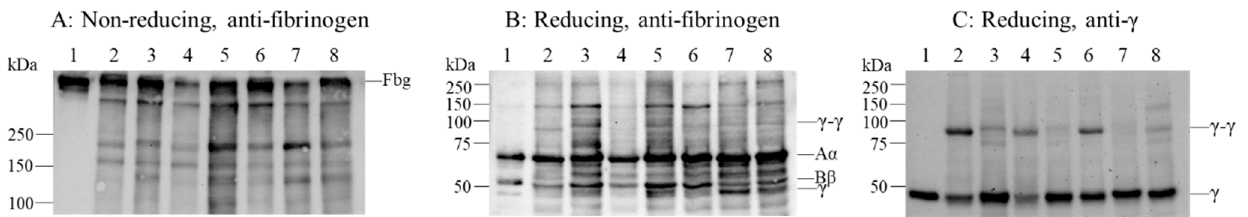
Figure 3. Immunoblotting analysis of recombinant fibrinogen. Fibrinogen in Chinese hamster ovary cell lysates were determined by Western blotting using anti-human fibrinogen antibodies in non-reducing conditions in a 8% polyacrylamide gel ( A ) or reducing conditions in an 10% polyacrylamide gel ( B ) and anti-human fibrinogen γ -chain antibodies in reducing conditions in an 10% polyacrylamide gel ( C ). Fibrinogen (Fbg), γ - γ dimer and A α , B β , and γ chain are indicated on the right side of each panel. Lane 1: purified fibrinogen, 2: wild-type, 3: γ L276P, 4: γ T277R, 5: γ T277P, 6: γ Y278H, 7: γ A279D, and 8: γ Y280C cell lines.